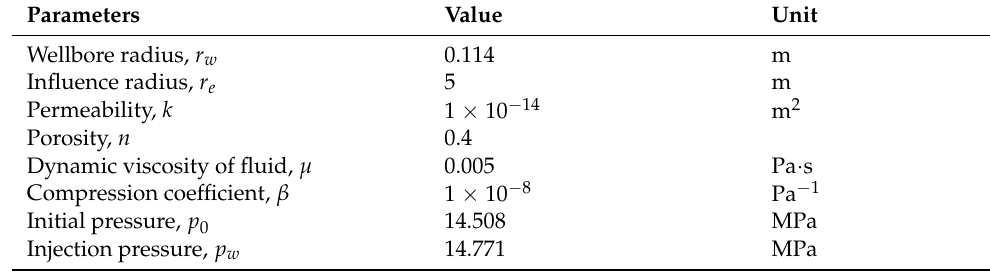
Table 3. Parameters employed in comparison with the numerical results (Sun et al., 2018) [44].